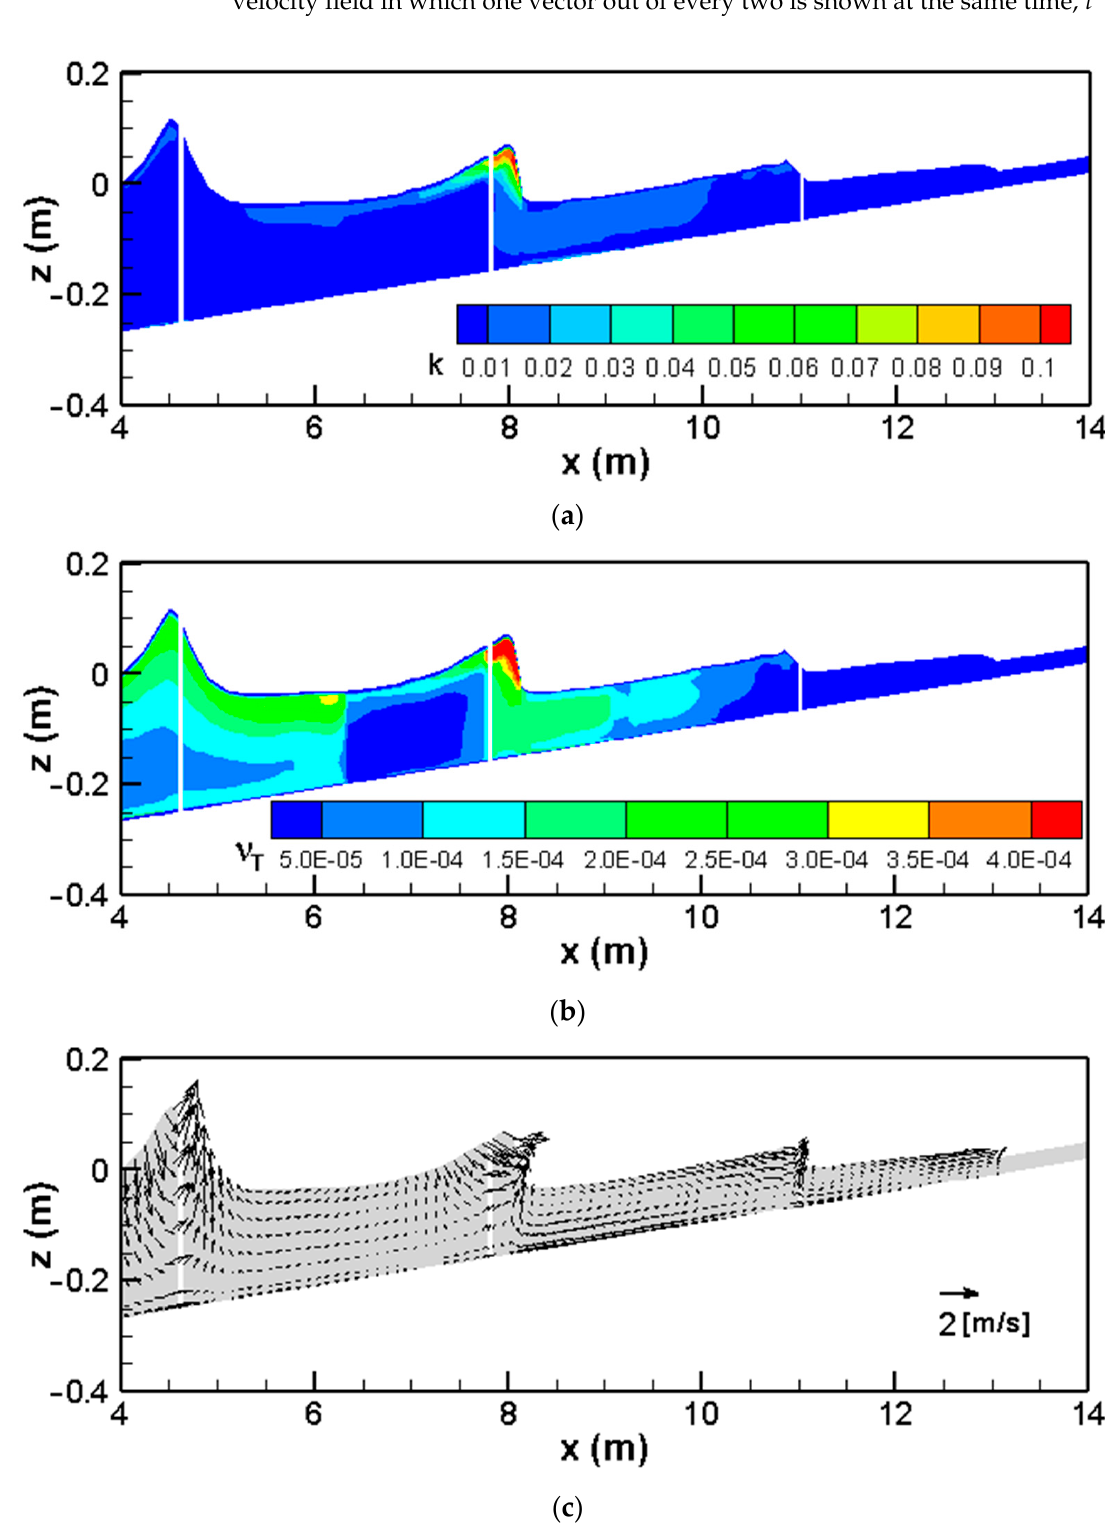
∼ = ( x 6.5 m − 7.5 m) because the mixing length (Equation (17)) reduces its value in this zone. Figure 17c,d represent, respectively, an instantaneous velocity field and a zoom of the same 𝑡 = 98.75 s .